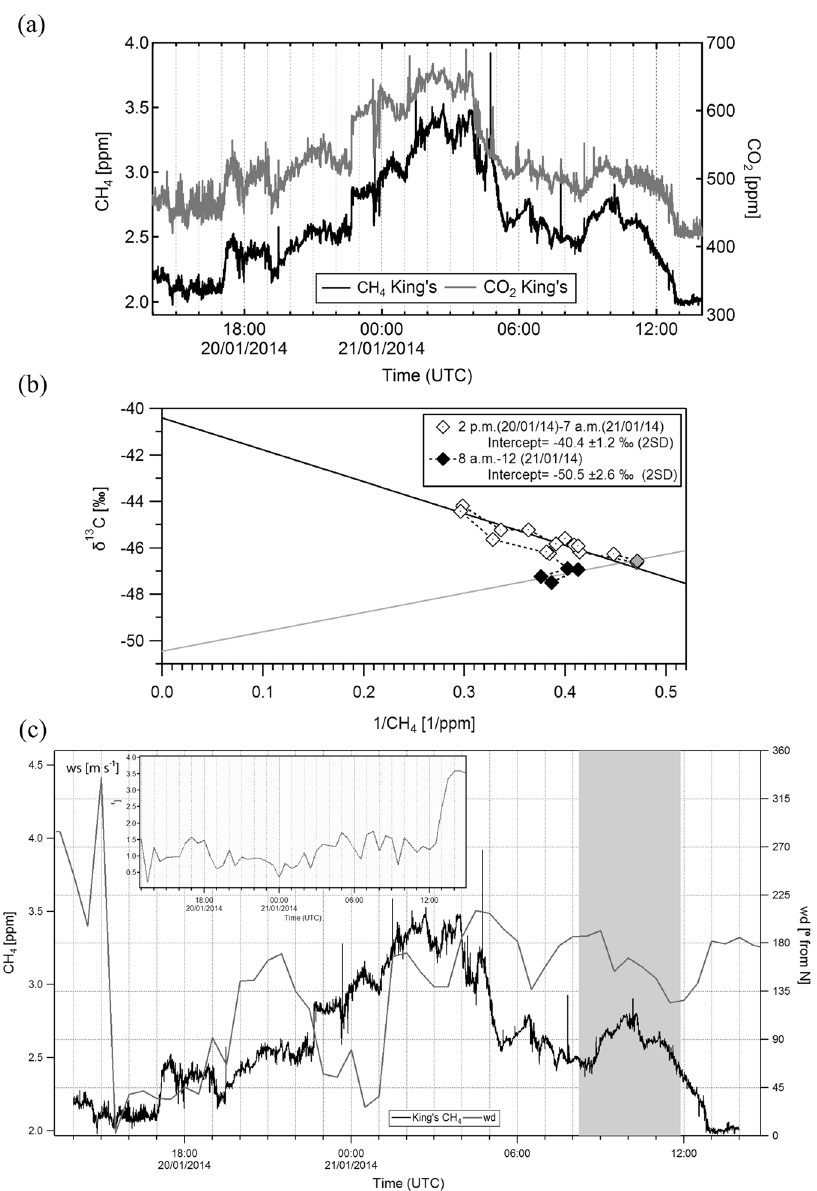
Figure 2. Observations at KCL roof on the 20 th and 21 st January 2014: ( a ) CH 4 and CO 2 mole fractions profiles ( b ) Keeling plots based on the samples collected during the 20 th and the early morning of the 21 st January 2014 (white markers), during the morning of the 21 st January 2014 (black markers), and background (grey marker) with the order of sampling (dotted line). ( c ) Wind direction (grey line), wind speed (line, inset graph) and CH 4 mole fractions (black line). Time interval of those samples that are thought to be associated with a biogenic CH 4 source indicated by grey